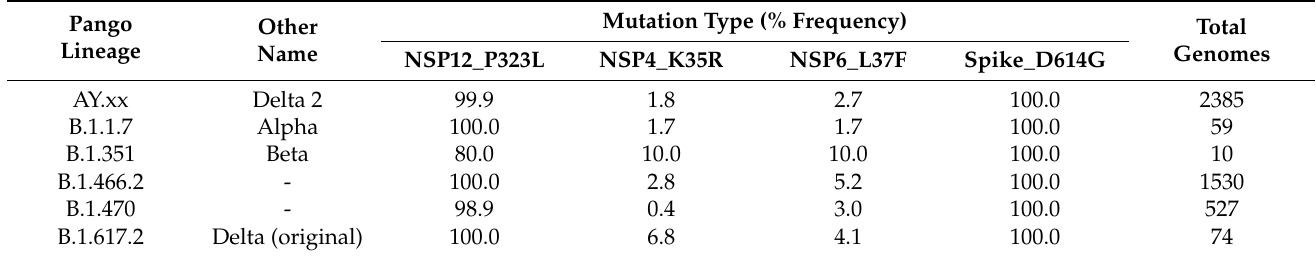
Table 3. Common mutations found in all listed variants (VoCs and Indonesian variants).